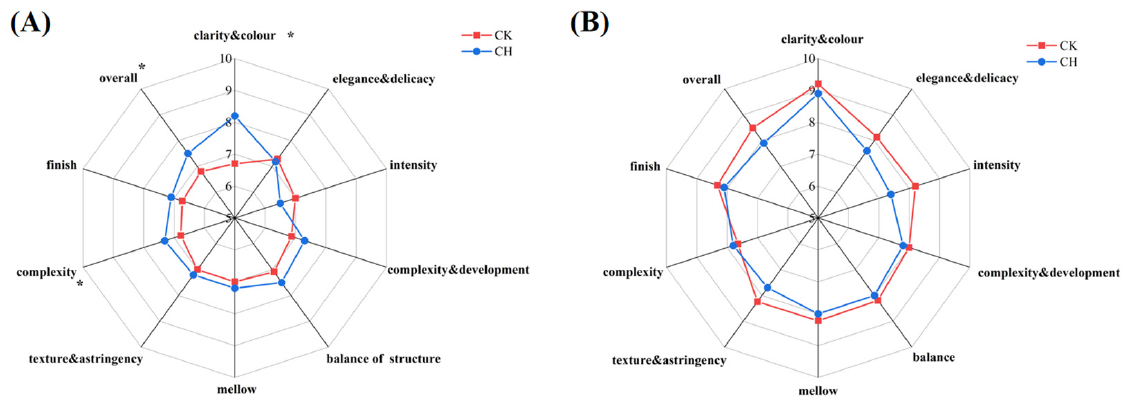
Figure 9. Effects of covering peanuts on the sensory evaluation of ‘Cabernet Sauvignon’ wines. ( A ) the wines of 2018; ( B ) the wines of 2019. * indicates significant differences between the control and covering purslane ( p < 0.05, t -test).